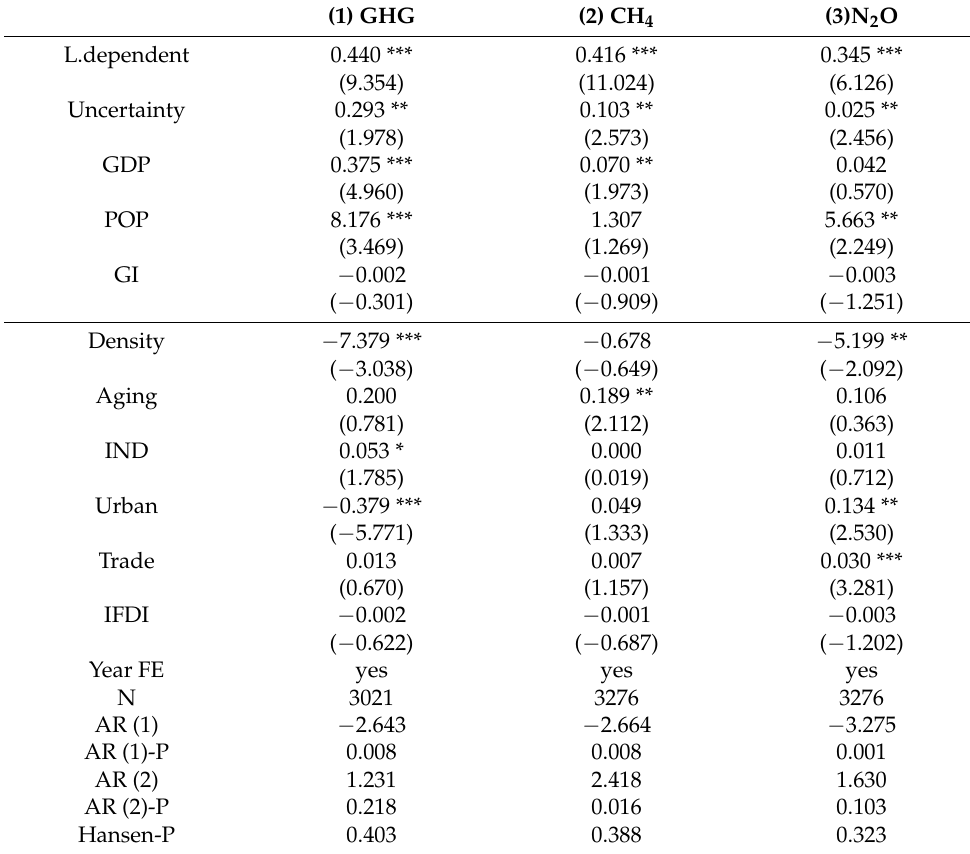
Table 5. Robustness test—changing the measurement of dependent